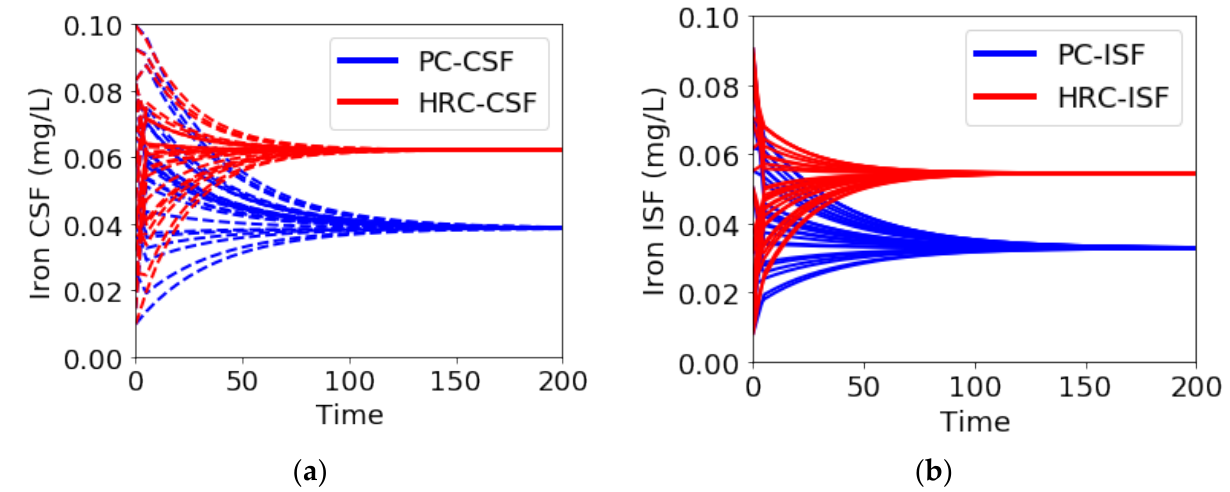
( a ) and ISF ( b ) start- 𝐼𝐼 𝐶𝐶𝐶𝐶𝐶𝐶 𝐼𝐼 𝐼𝐼𝐶𝐶𝐶𝐶